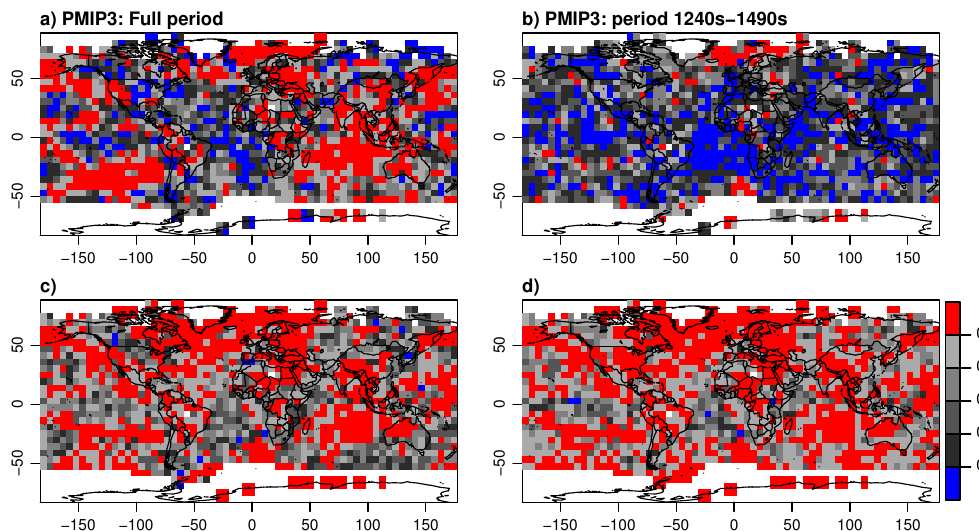
Fig. 1. Global assessment of the goodness-of-fit test for the field data considering uncertainties in the verification target. Plotted are lower p values for tests performed at each individual grid point. In the upper row: full χ 2 test; in the lower row: maximum of p values for single deviation tests for bias and spread. The maximum of both p values highlights grid points where at least one test is significant. Blue indicates smaller than 0.1, dark to light grey in steps of 0.2 within 0.1 and 0.9, red larger than 0.9. Red means rejection of the uniform null